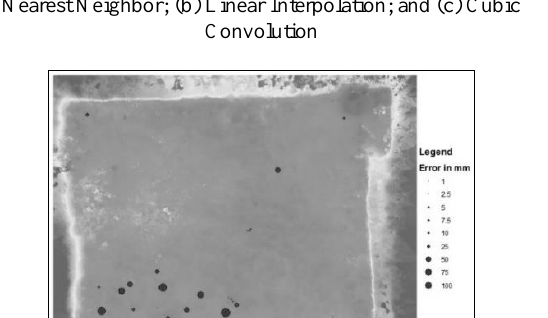
Figure 8. RMSE of the generated DEMs for Site A using (a) Nearest Neighbor; (b) Linear Interpolation; and (c) Cubic